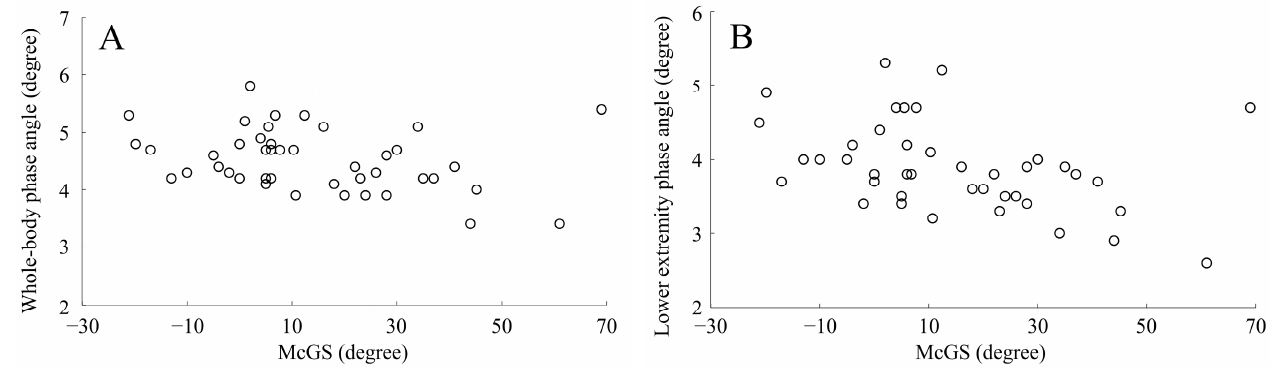
Figure 4. Correlation between McGS and phase angles in the IDHS group. ( A ) Correlation between McGS and whole ‐ body phase angle; ( B ) correlation between McGS and lower extremity phase angle. Abbreviations: McGS, McGregor’s slope. Abbreviations: McGS, McGregor’s